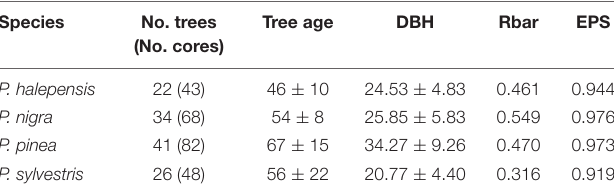
The estimated tree age at coring height (1.3 m) and the diameter at breast height (DBH; 1.3 m) are shown together with the Rbar and the EPS. Rbar is the mean correlation among trees’ series and EPS is the Expressed Population Signal. Values are means ± SD.